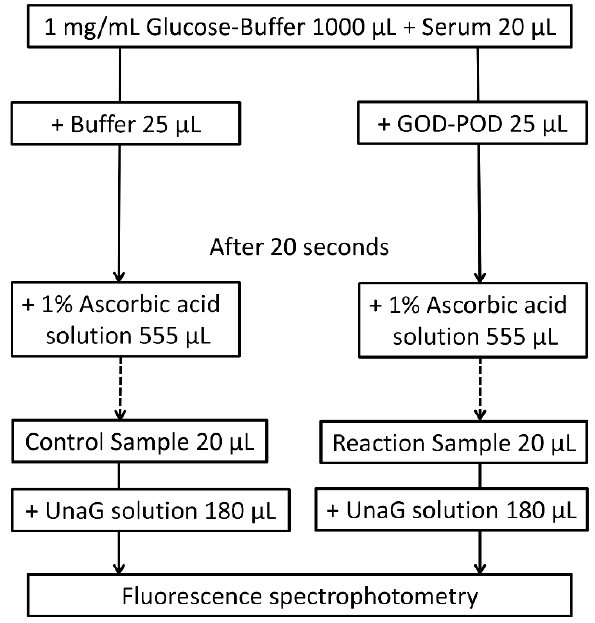
Figure 6. GOD–POD–UnaG method protocol. GOD, glucose oxidase; POD, peroxidase; UnaG, bilirubin-inducible fluorescent protein from eel muscle.